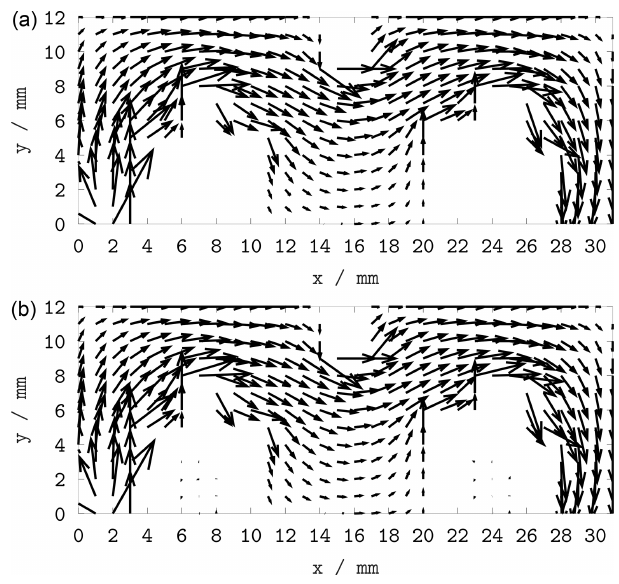
Figure 4. Current distribution in the resistive element at the signal frequency 10Hz (a) and 100kHz (b) .